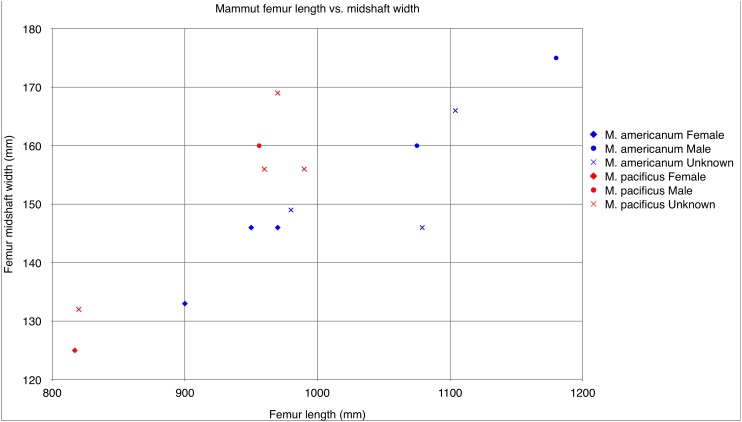
Mammut femur length vs. mid shaft width.Comparison of length vs. width measurements in Mammut pacificus (red) and Mammut americanum (blue). Measurements follow Hodgson et al. (2008a).